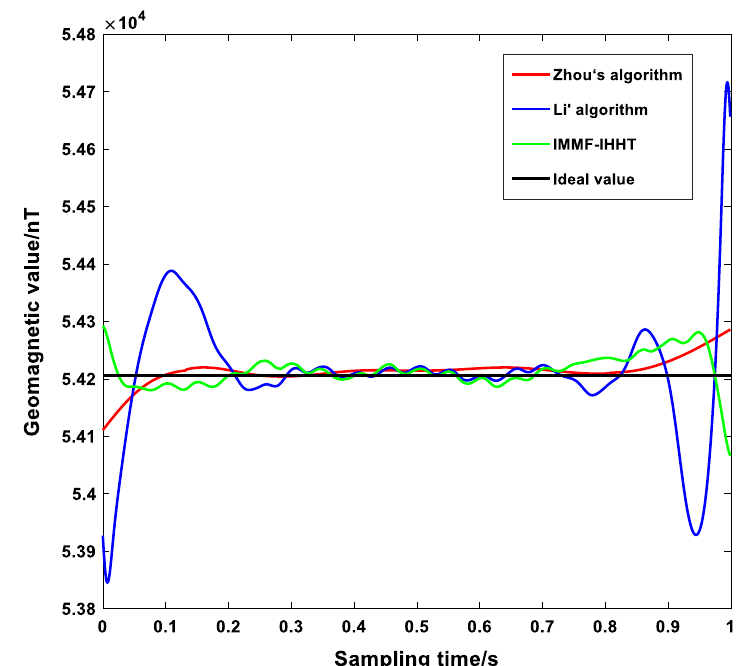
Fig. 19 Comparison of denoising effects of three algorithms